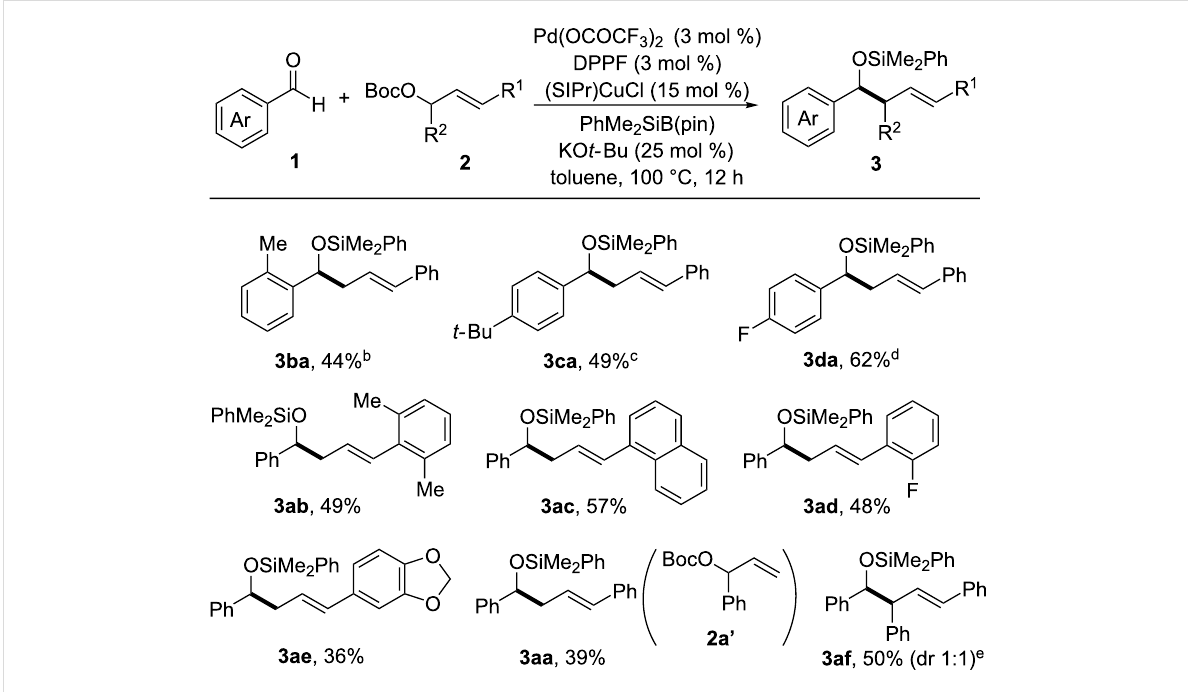
Scheme 3: Substrate scope and reaction conditions. a) reactions were carried out with 1 (0.4 mmol), 2 (0.2 mmol), PhMe 2 SiBpin (0.4 mmol), Pd(OCOCF